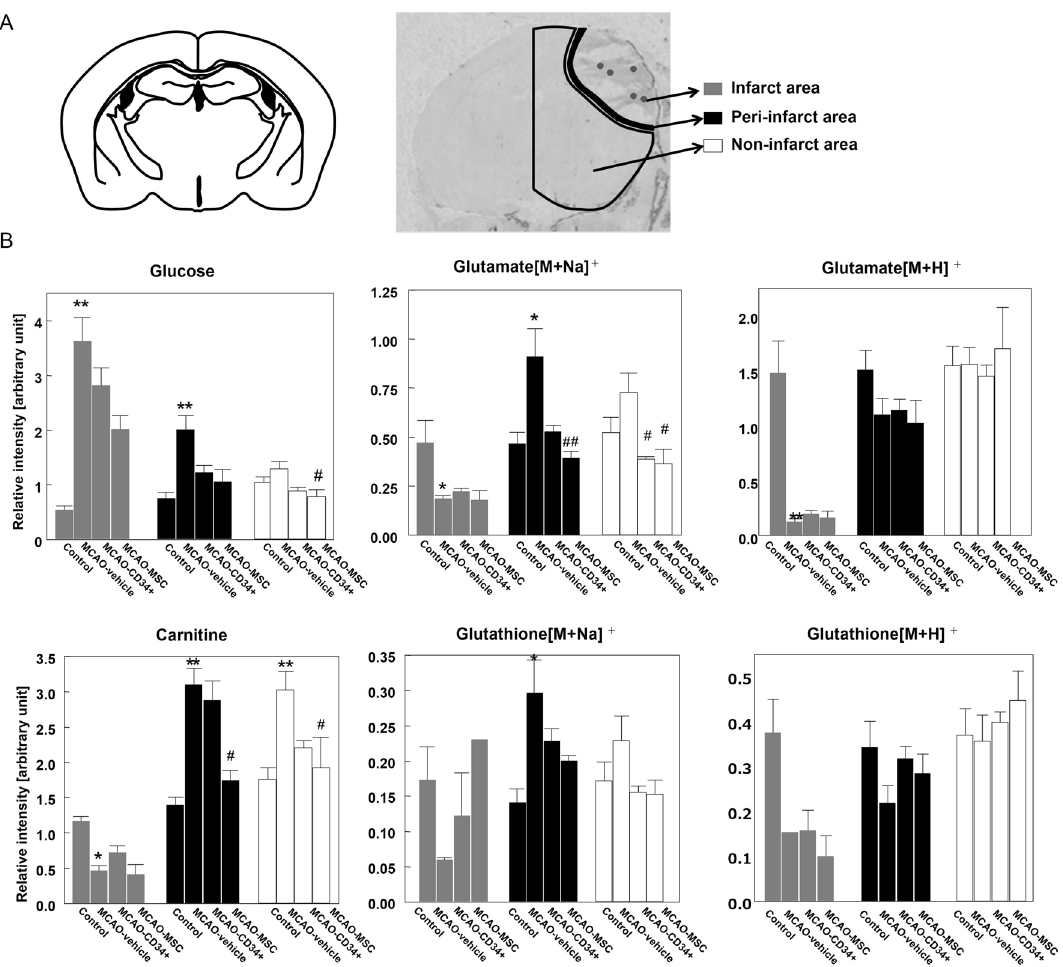
the peri-infarct area, and the non-infarct area. ( A ) A schematic illustration representing the region of interest (ROI) that we used. As a control, we used the contralateral sides of brains from MCAO-vehicle mice. ( B ) The bar graph represents the average intensity of each ROI. Data are shown as the mean ± the S.E.M. of five mice for each group. * and ** indicate p < 0.05 and p < 0.01 versus the control group, respectively, and # and ## indicate p < 0.05 and p < 0.01 versus the MCAO-vehicle group,